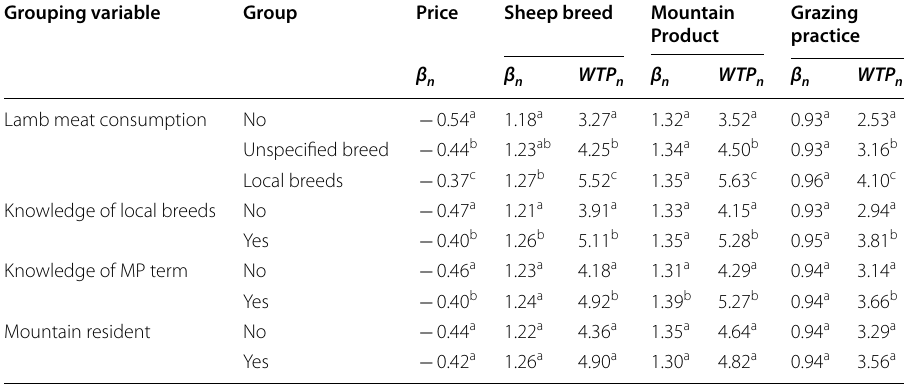
Superscript letters indicate whether the group means are statistically different at the 5% level, according to a Tukey test or a t test